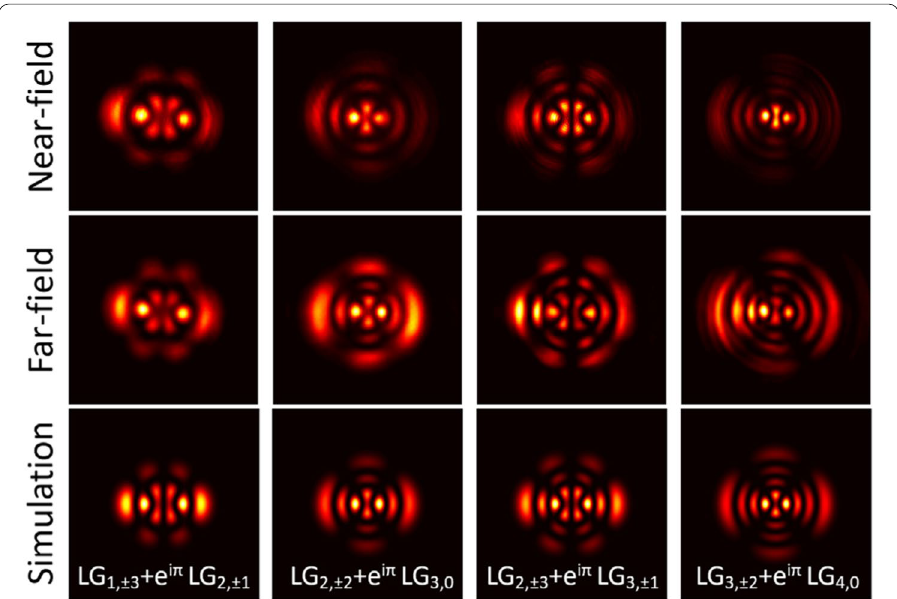
Fig. 7 Typical beam patterns obtained with different δ , when using lenses of f 1 under a pump power of 1.03 W